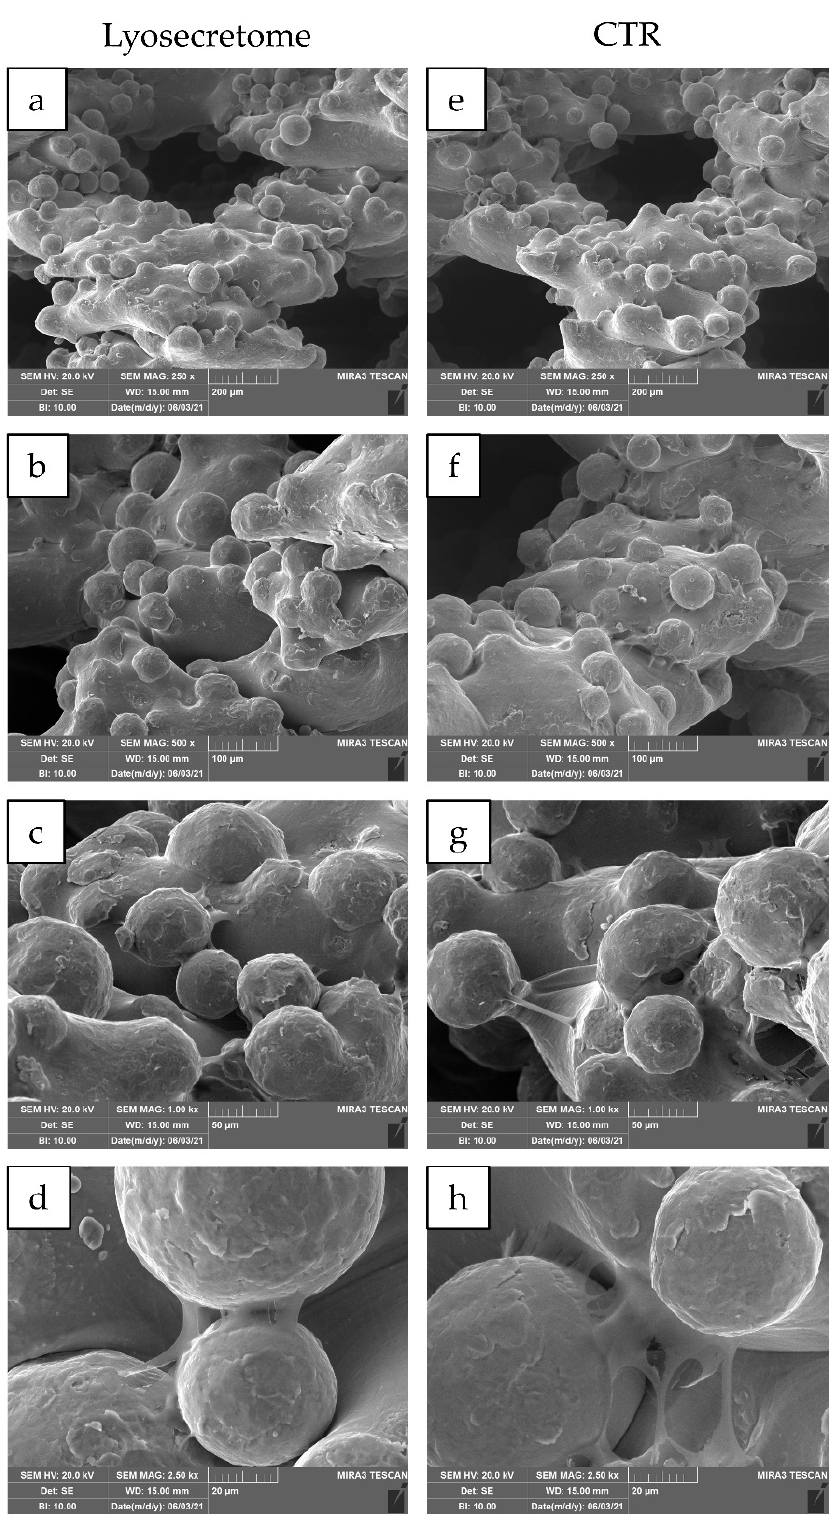
Figure 6. SEM morphological and structural characterizations of titanium cages seeded with MSCs and cultured in osteogenic medium with Lyosecretome or without (CTR) for 21 days. Magnifications: 250 × ( a , e ), 500 × ( b , f ), 1000 × ( c , g ), and 2500 × ( d , h ). Scale bars: 200 ( a , e ), 100 ( b , f ), 50 ( c , g ), and 20 ( d , h ) µm.